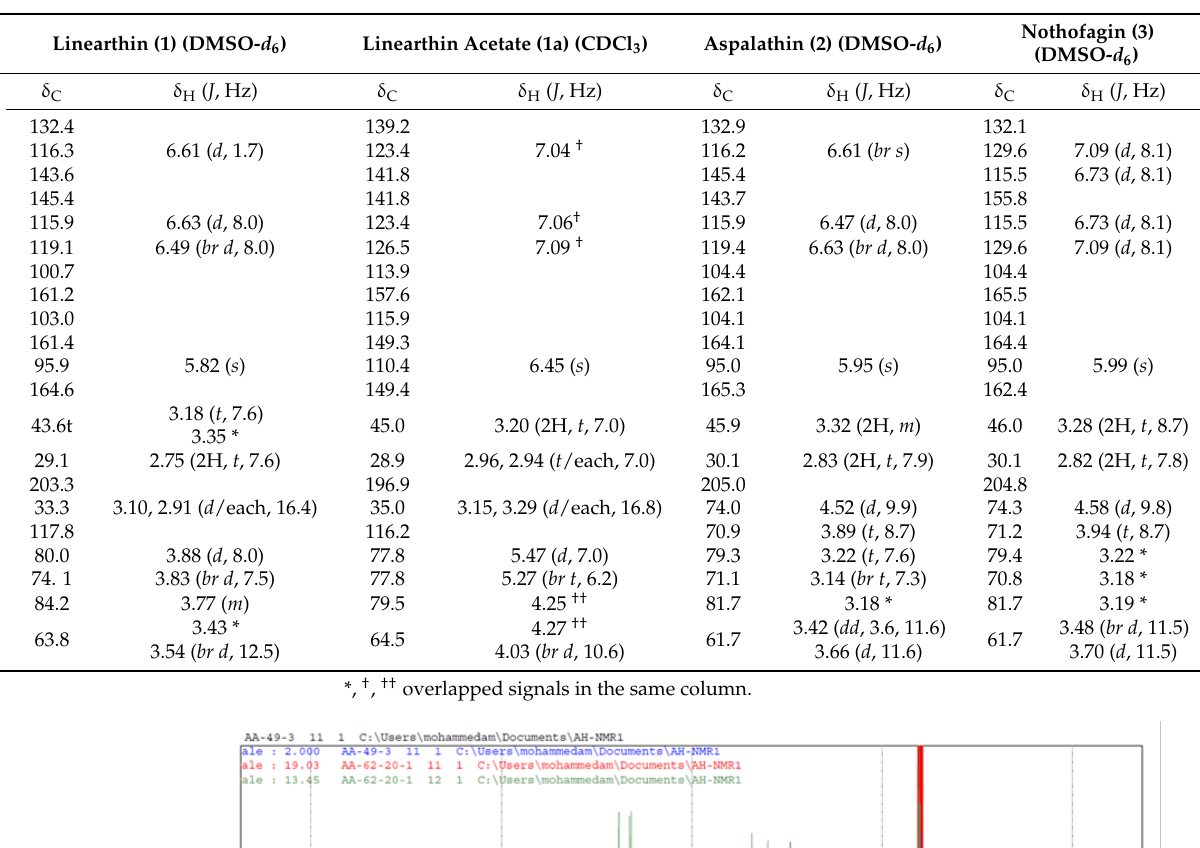
Table 1. 1 H- and 13 C-NMR data for compounds 1 – 3 .